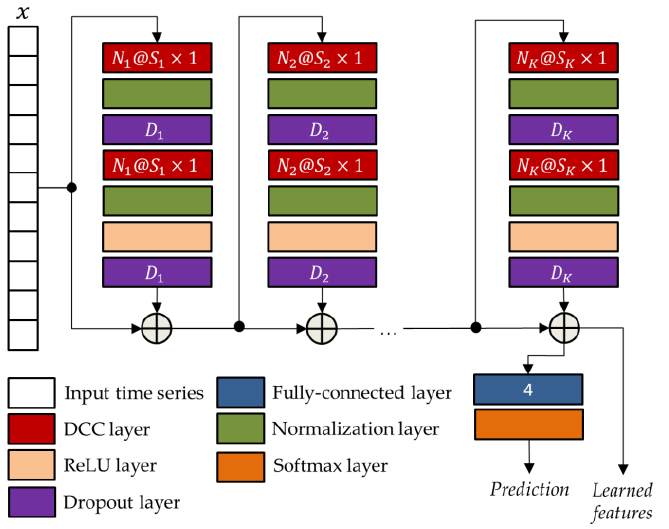
Figure 5 . The general TCN architecture with 𝐾 residual blocks. Figure 5. The general TCN architecture with K residual blocks.